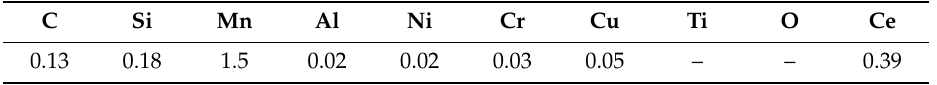
Table 1. Nominal chemical composition for S355 steel.